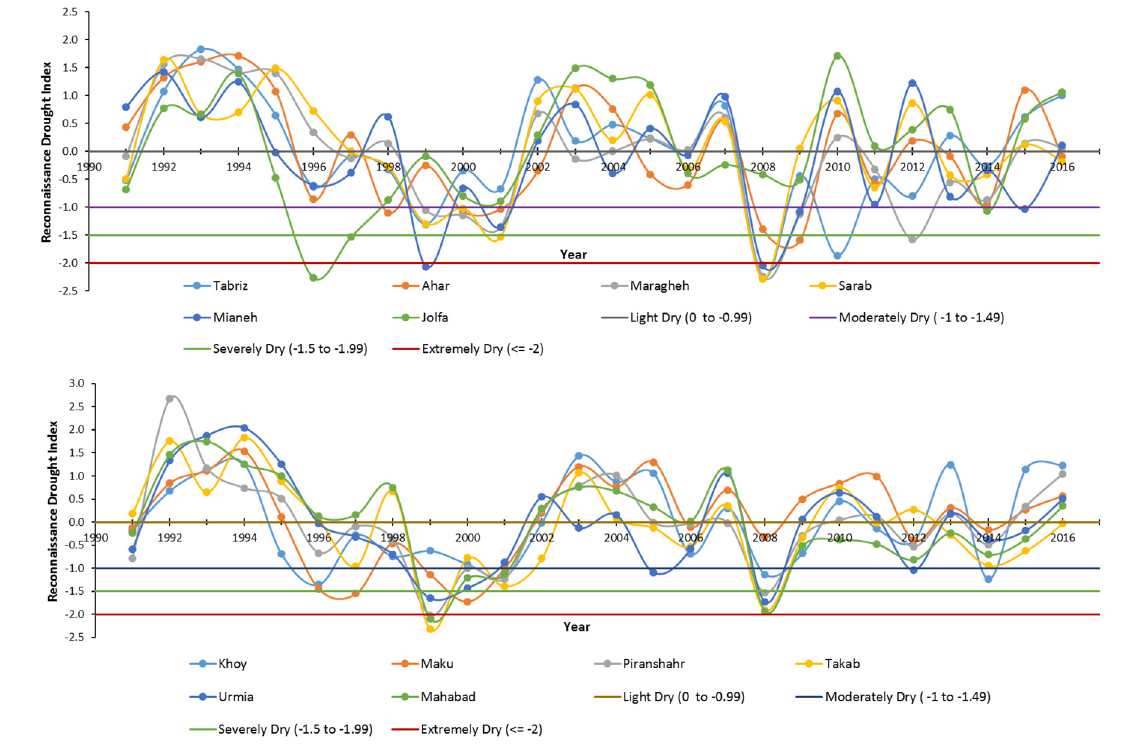
Figure 5. The wheat growing season Reconnaissance Drought Index (RDIst) graph (Oct–Jun) for target counties of East Azerbaijan and West Azerbaijan provinces.